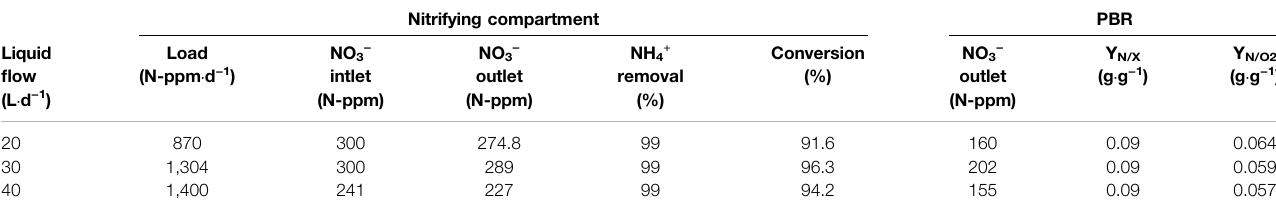
TABLE 4 | Nitrogen balances observed in nitrifying bioreactor and photobioreactor for every experimental condition during liquid connection between nitrifying and photosynthetic compartments and gas connection between photosynthetic and crew compartment. The outlet of NO 3 − from nitrifying bioreactor is considered as the inlet concentration in the